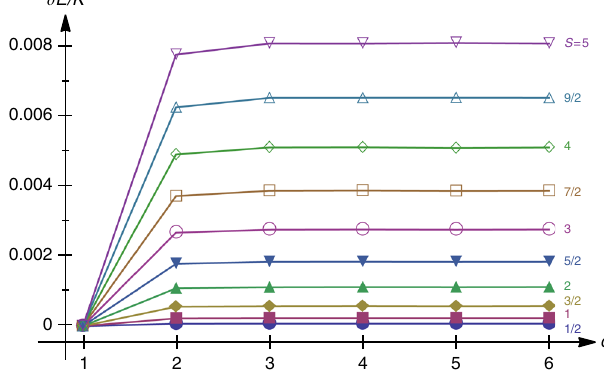
Fig. 5 Magnetic fl ux decon fi nement. Energy of a con fi guration with two magnetic fl uxes as a function of the distance d between the associated empty hexagons, for spins S = 1/2 (bottom line) up to S = 5 (top line). The energy is measured from the value at nearest-neighbor separation d =